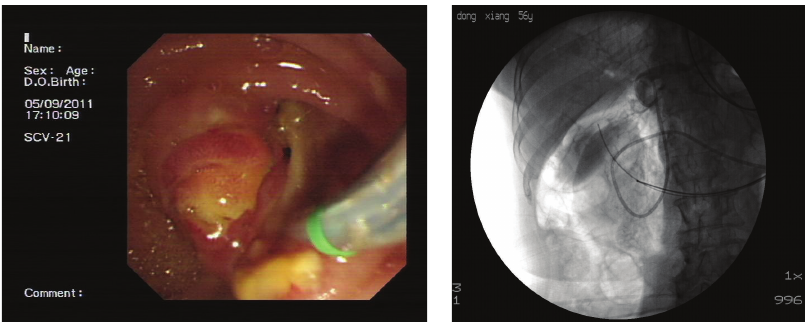
Figure 2: Pre-ampullary perforation by cutting. The kidney shadow was shown by